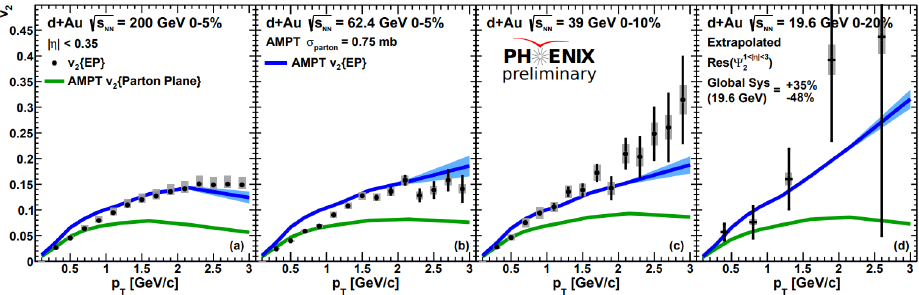
Figure 6. Elliptic (v 2 ) flow measured for charged hadrons in 0-5% most central d + Au collisions at  s NN = 200, 62.4, 39 and 19.6 GeV compared the AMPT model